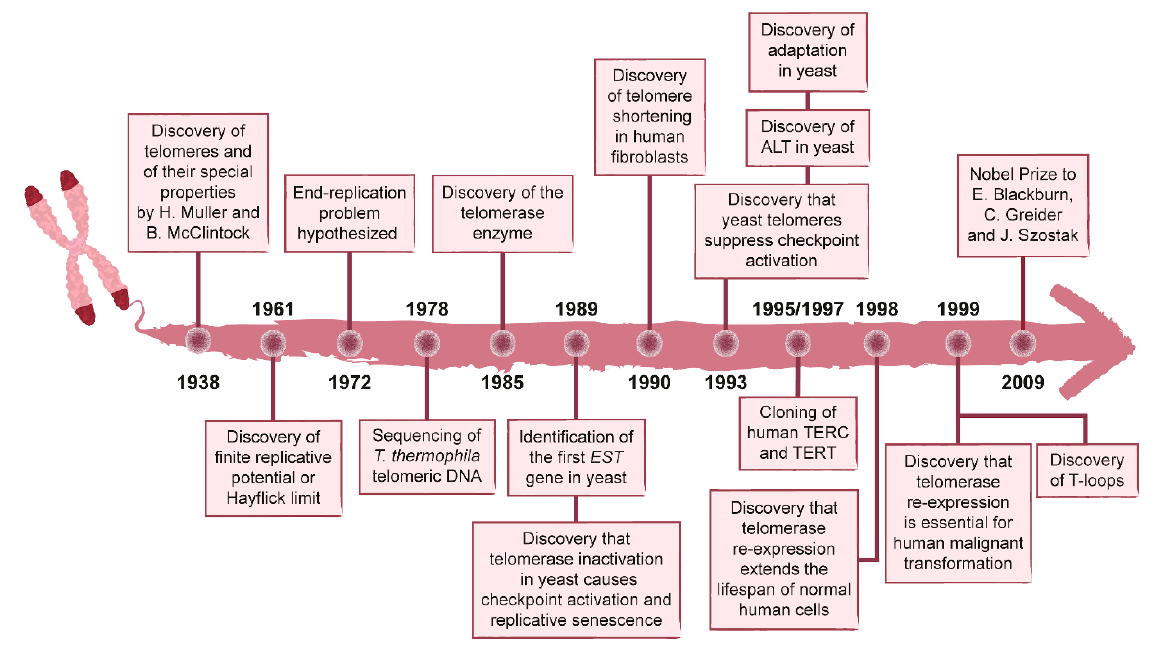
Figure 1. Timeline of the major discoveries in the telomere field.